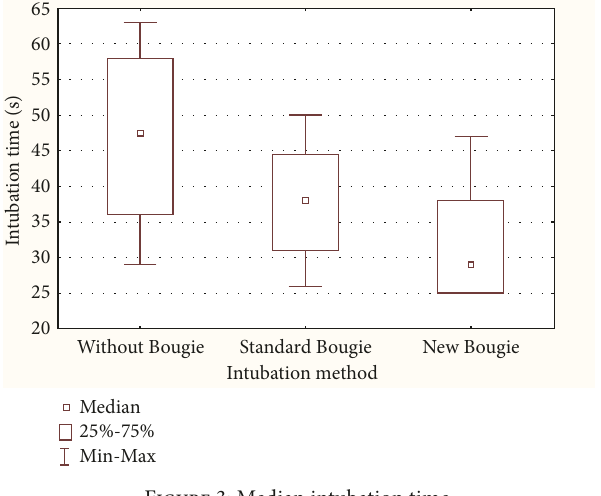
Figure 3: Median intubation time. Figure 4: Ease of use